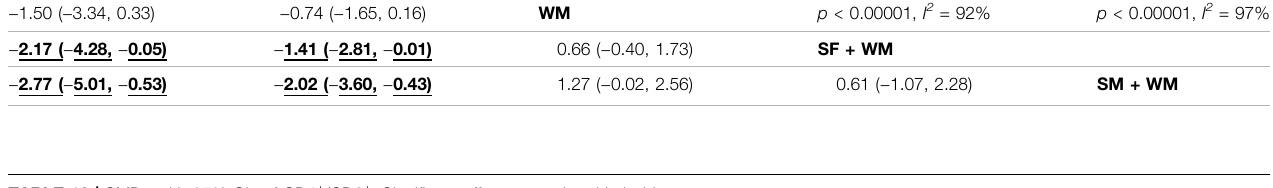
TABLE 10 | SMDs with 95% CIs of CD4 + /CD8 + . Signi fi cant effects are printed in bold. HQ + WM 0.45 ( − 0.39, 1.32) SM + WM p = 0.27, I 2 = 17% 0.48 ( − 0.28, 1.25) 0.64 ( − 0.19, 1.45)